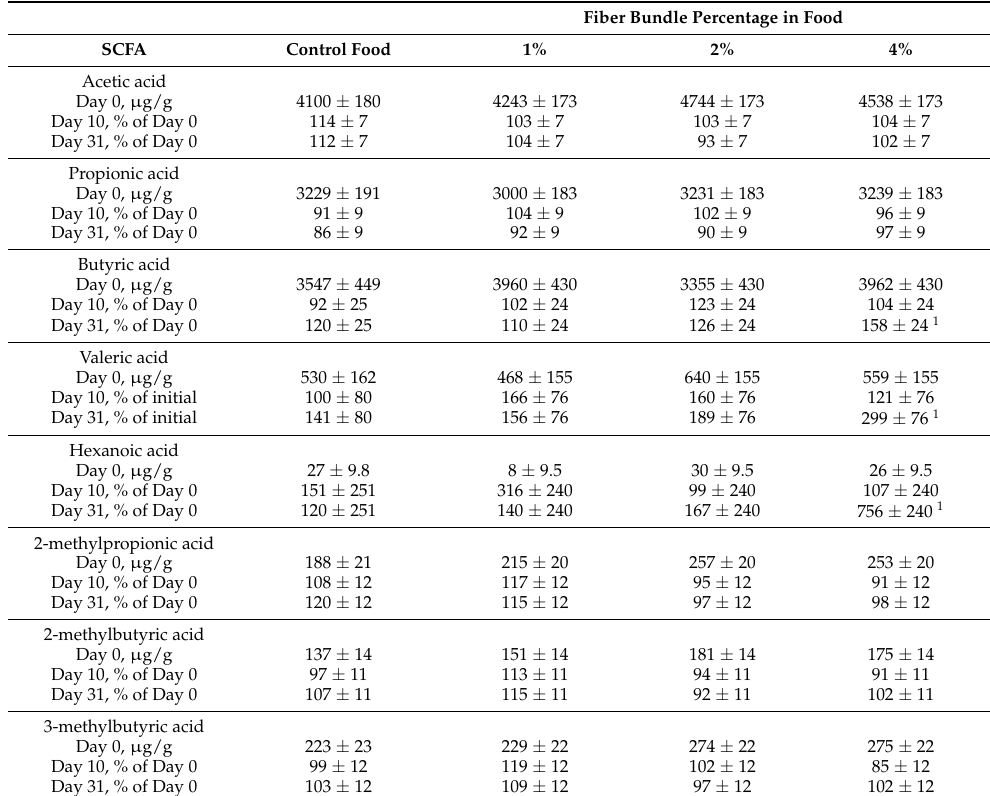
Table 4. Fecal short-chain fatty acids at baseline (Day 0) and Days 10 and 31 in dogs that consumed foods containing 0%, 1%, 2%, or 4% of added fiber-bound polyphenol